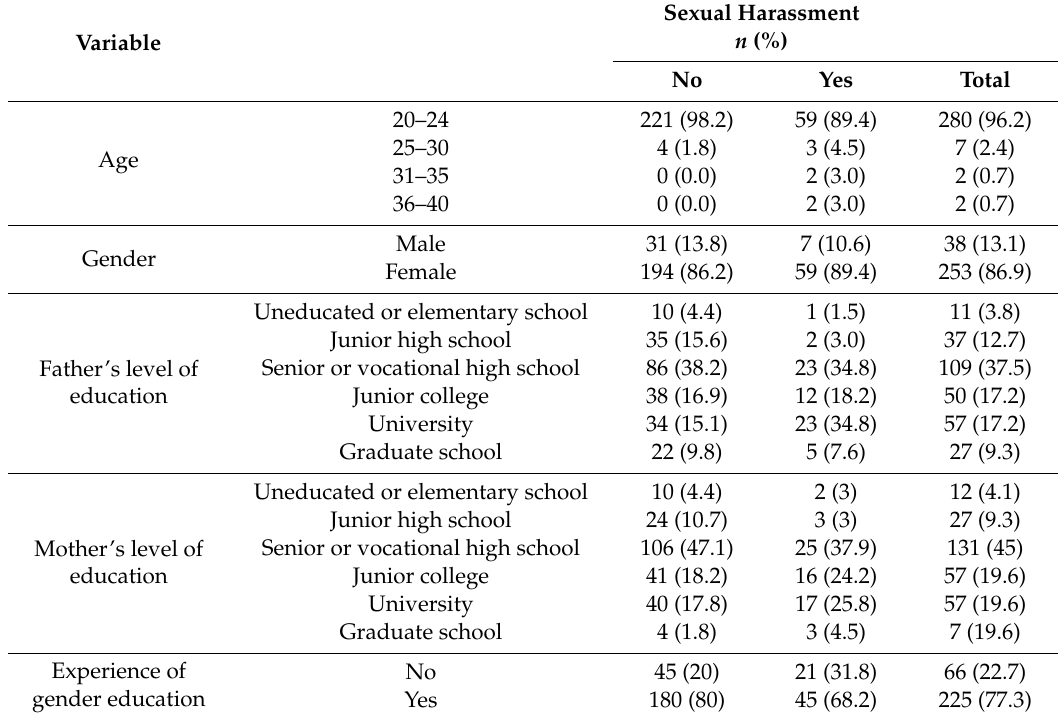
Table 1. Demographic characteristics and selected variables ( n =